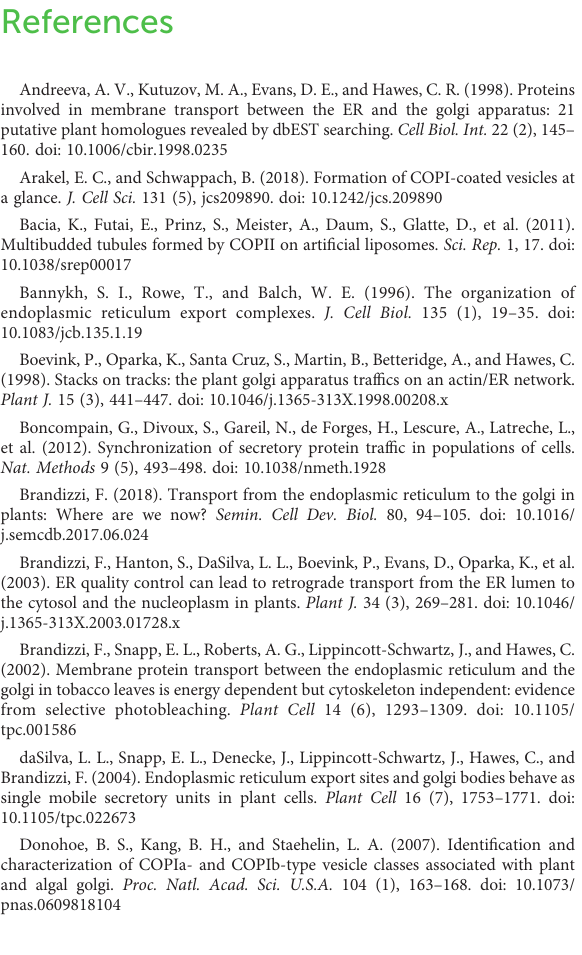
SUPPLEMENTARY FIGURE 1 Video tobacco transiently expressing GFP-HDEL and ST-mRFP. SUPPLEMENTARY FIGURE 2 (A, B) Videos Arabidopsis stably transformed with GFP-HDEL and